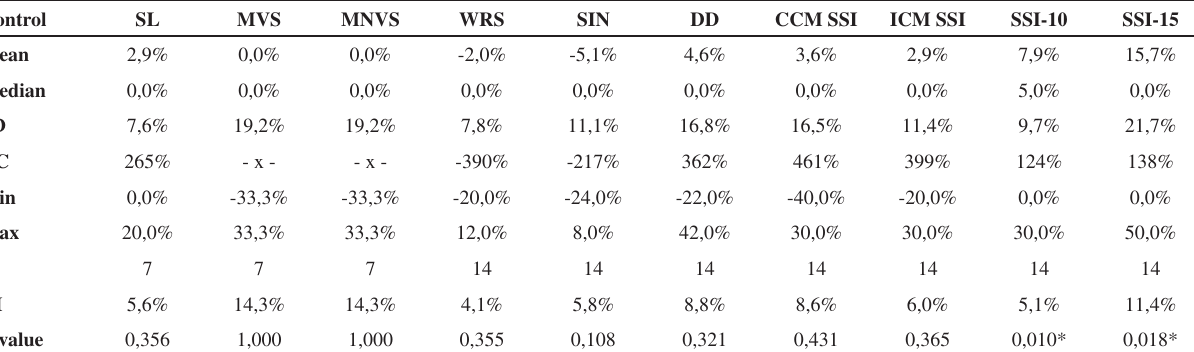
Table 2 - Amount of improvement in behavioral auditory processing tests for the control group when comparing pre- and post-training